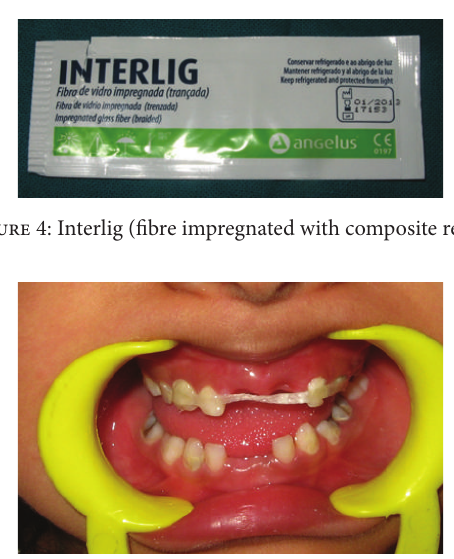
Figure 5: “Interlig” bonded to grooves in abutment teeth.